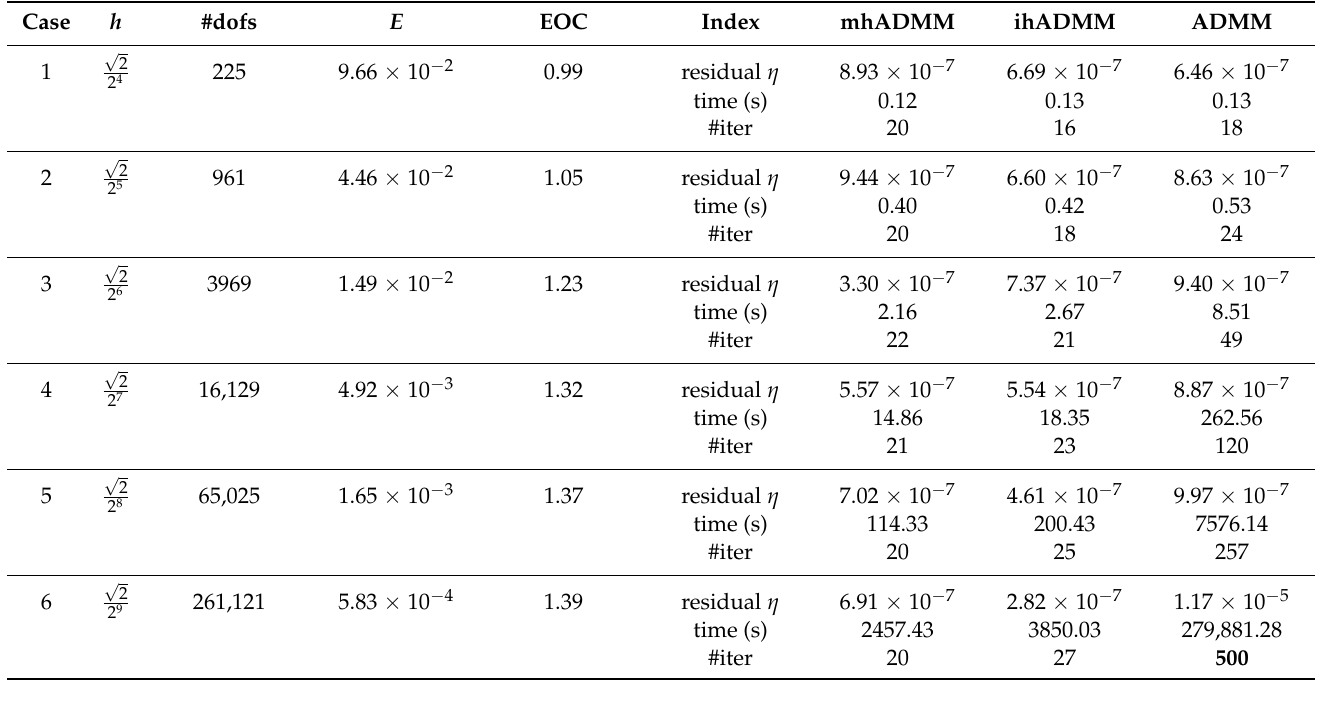
Table 1. The convergence behavior of the mhADMM, the ihADMM and the classical ADMM for Example 1.